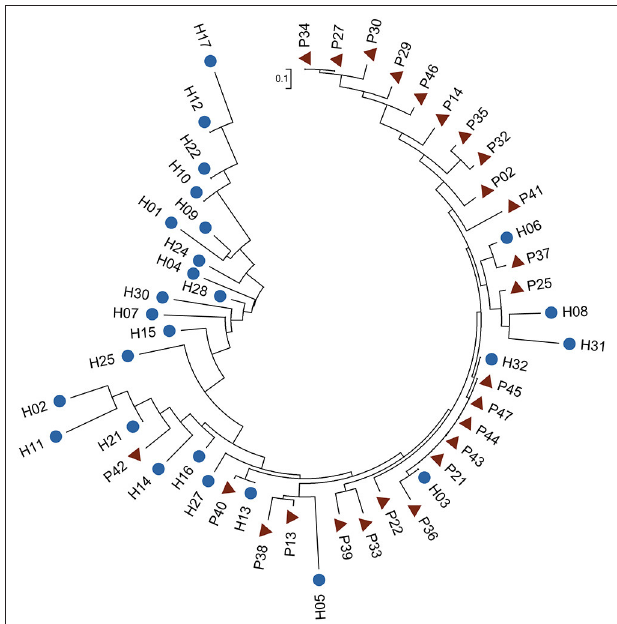
FIGURE 4 | Phylogenetic tree of B. vulgatus based on differentially distributed core-genome SNPs. Fisher’s exact test was performed to test the differences in SNP distribution ( P < 0.01). The ML tree was constructed in MEGA 6 with 1,000 bootstrap replicates. Blue dots and red triangles indicate controls and patients,